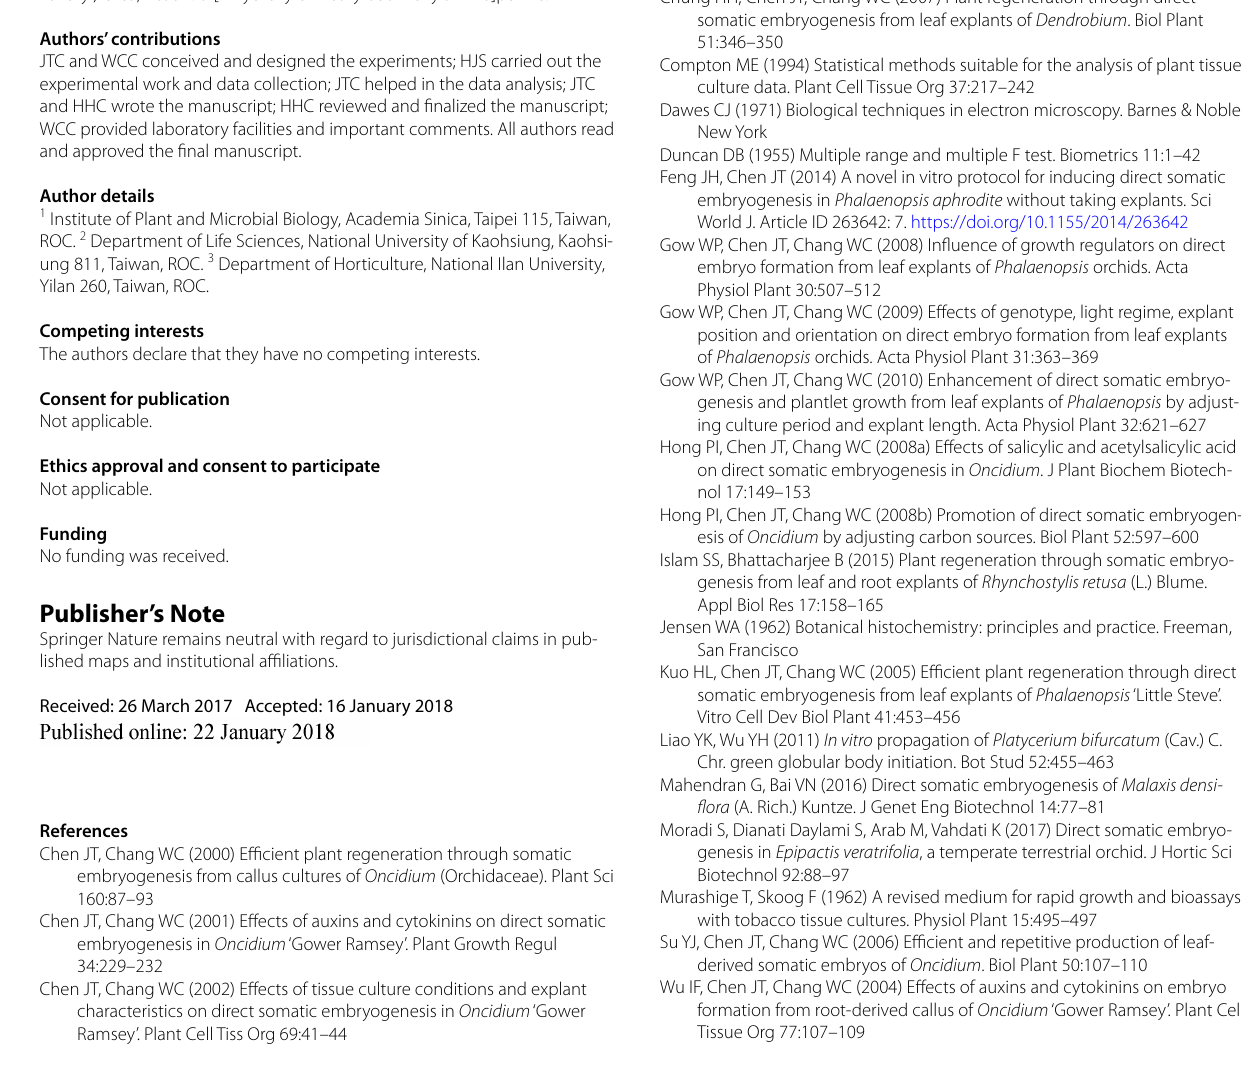
Means within a column followed by the same letter are not significantly different according Duncan’s multiple range test at p